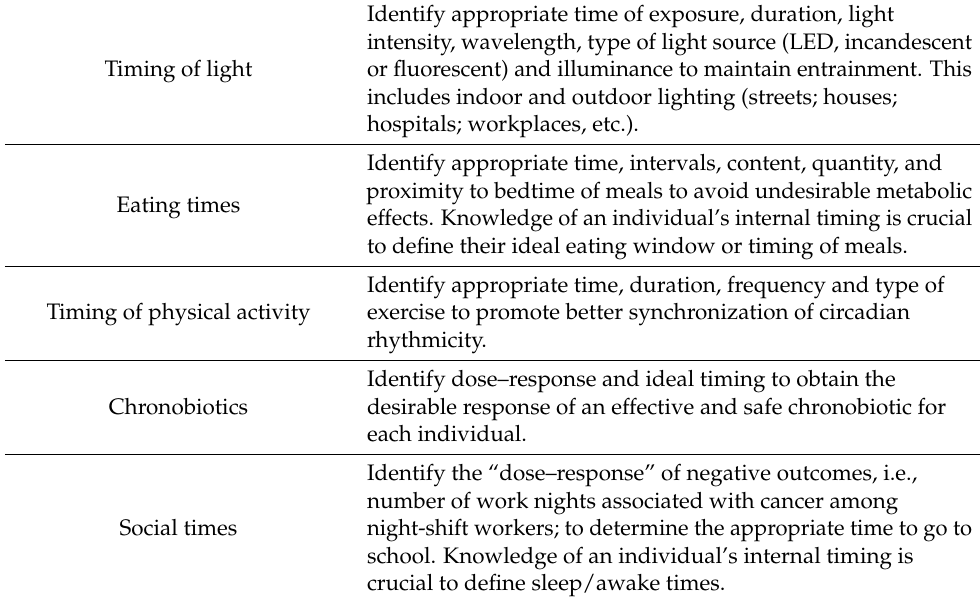
Table 2. Research agenda. To refine recommendations and put these into practice on a large scale, further knowledge must be acquired on the effects of several factors on the circadian system, taking into account age, sex, ethnic and chronotype differences. Identify appropriate time of exposure, duration, light intensity, wavelength, type of light source (LED, incandescent Timing of light or fluorescent) and illuminance to maintain entrainment. This includes indoor and outdoor lighting (streets; houses; hospitals; workplaces, etc.). Identify appropriate time, intervals, content, quantity, and proximity to bedtime of meals to avoid undesirable metabolic Eating times effects. Knowledge of an individual’s internal timing is crucial to define their ideal eating window or timing of meals. Identify appropriate time, duration, frequency and type of Timing of physical activity exercise to promote better synchronization of circadian rhythmicity. Identify dose–response and ideal timing to obtain the Chronobiotics desirable response of an effective and safe chronobiotic for each individual. Identify the “dose–response” of negative outcomes, i.e., number of work nights associated with cancer among Social times night-shift workers; to determine the appropriate time to go to school. Knowledge of an individual’s internal timing is crucial to define sleep/awake